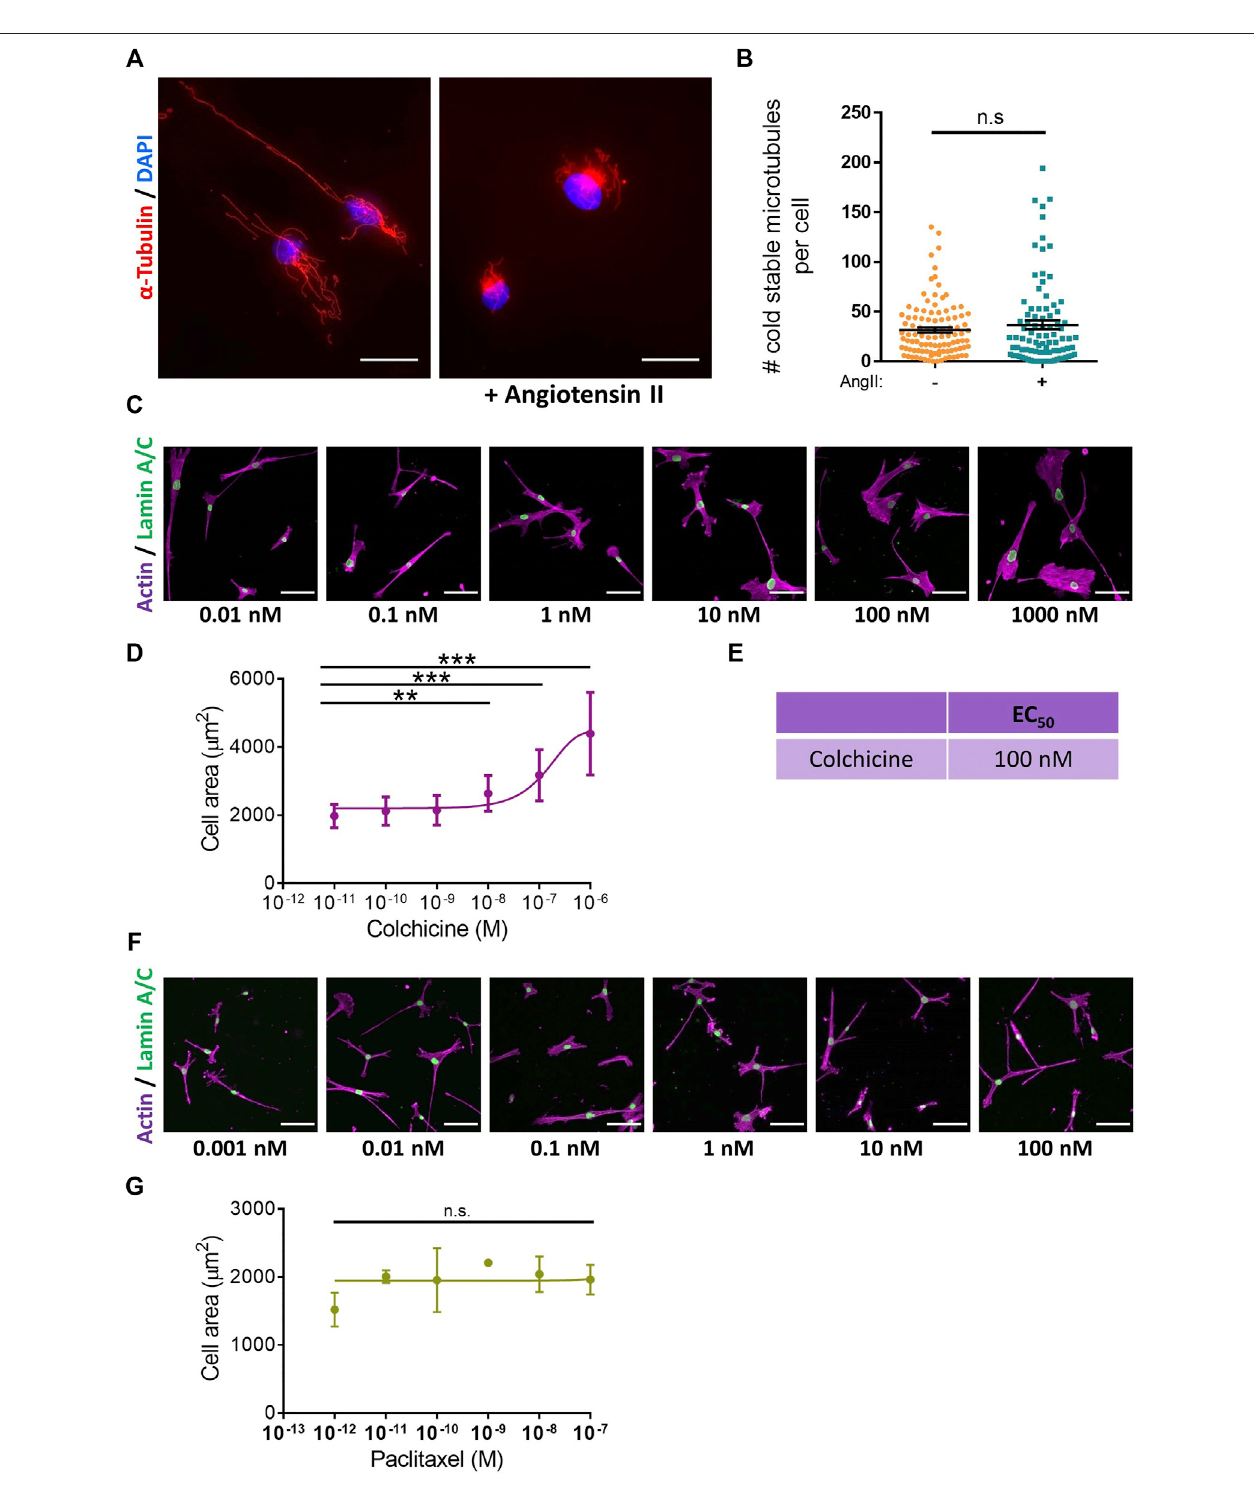
FIGURE 4 | Microtubule destabilisation prevents angiotensin II induced changes in VSMC area. (A) Representative images of isolated VSMCs cultured on 12 kPa polyacrylamide hydrogels, stained for cold-stable microtubules ( α -tubulin, red) and cell nuclei (DAPI, blue). Scale bar = 50 µm. Angiotensin II (AngII) (10 µM) stimulation was performed for 30 min. (B) Number of cold-stable microtubules per cell, representative of 4 independent experiments, with ≥ 90 cells analysed per condition. (C) Representative images of isolated VSMCs cultured on 12 kPa hydrogels pre-treated with a range of colchicine concentrations for 30 min prior to cotreatment with angiotensin II (10 µM) for an additional 30 min. Actin cytoskeleton (purple) and Lamin A/C (green). Scale bar = 100 μ m. (D) Isolated VSMC area, representative of 3